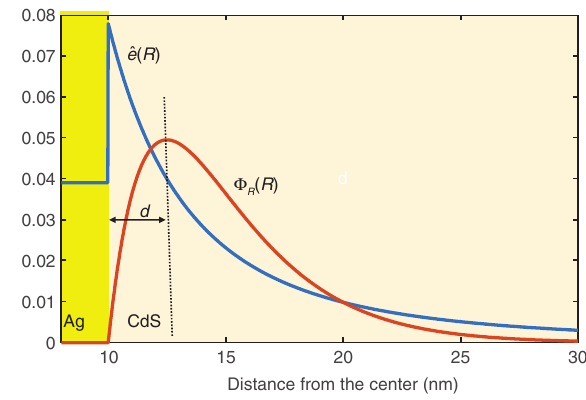
Figure 2: Overlap between the electric field distribution of the plasmon mode ˆ( ) e R and center-of-mass exciton wavefunction Ф of the WEPP.